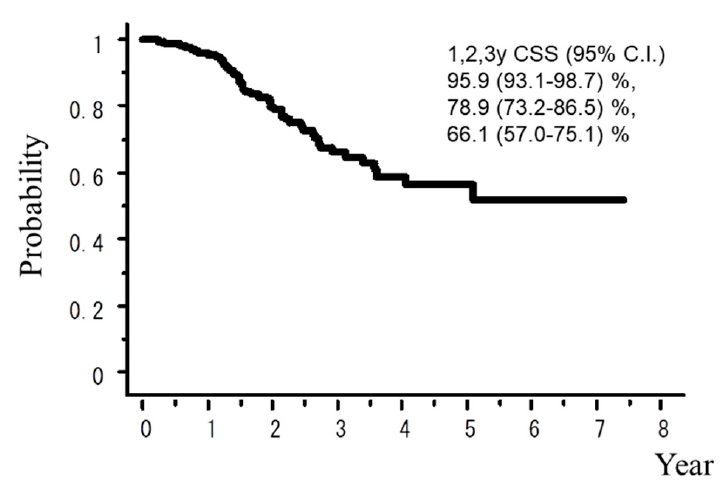
Figure 2. Cause-specific survival rate.